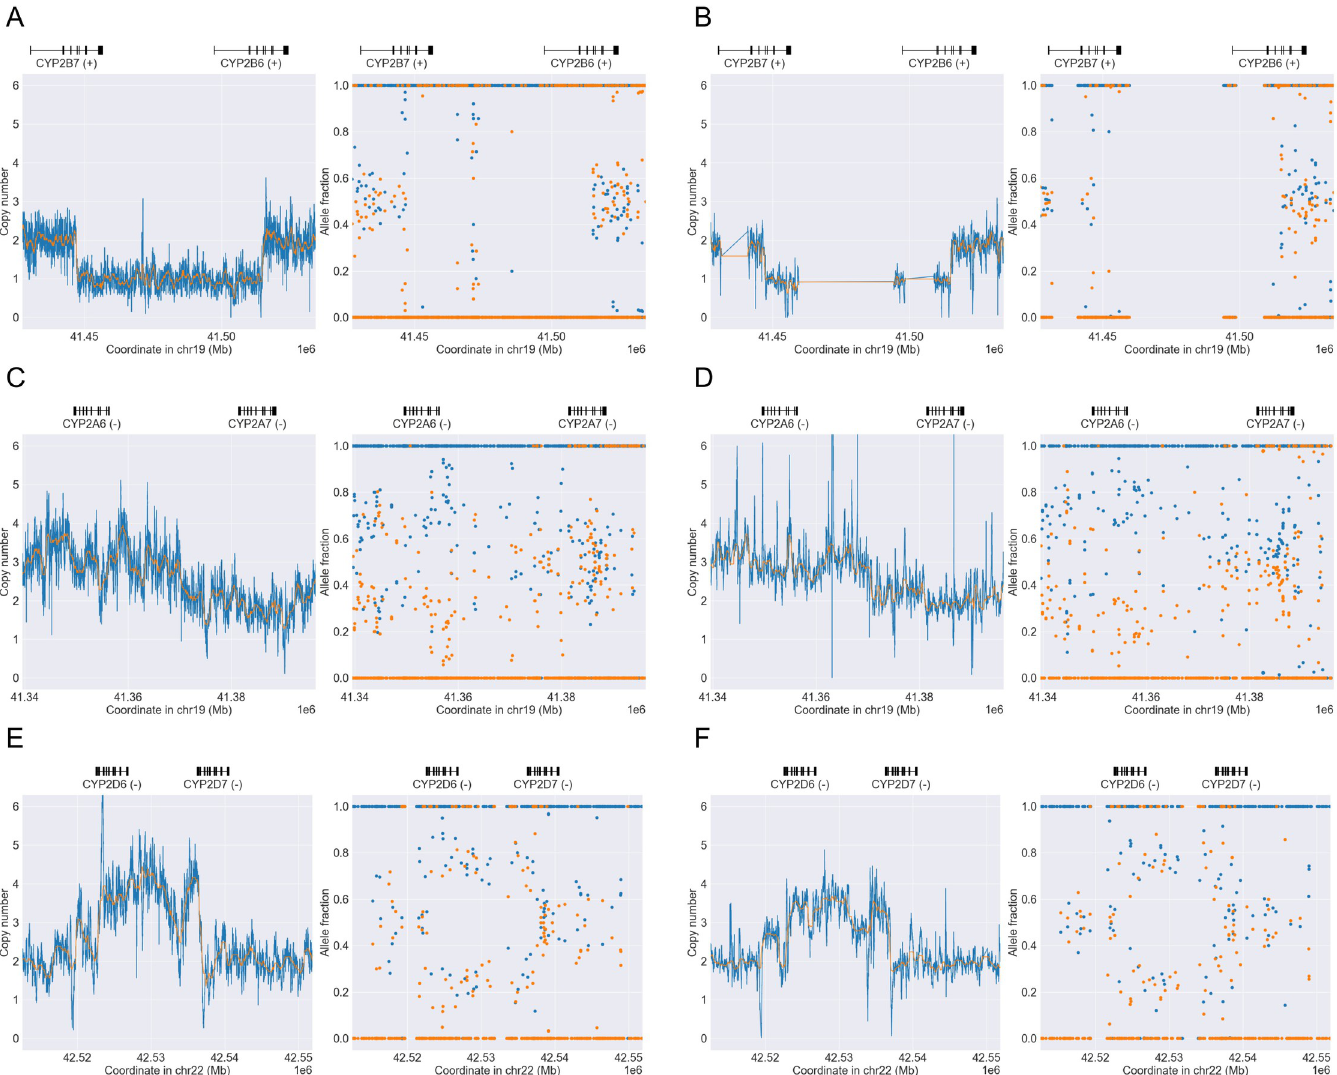
Fig 4. Examples of SVs detected with WGS and ClinPharmSeq. WGS data are shown in the left panels (A, C, and E) while ClinPharmSeq data are shown in the right panels (B, C, and D). Each panel contains a copy number profile and an allele fraction profile created by PyPGx. (A-B) CYP2B7/CYP2B6 hybrid in African sample NA19178 with a CYP2B6 � 6/ � 29 diplotype. (C-D) Gene duplication in African sample NA18861 with a CYP2A6 � 1x2/ � 25 diplotype. (E-F) Complex CYP2D6/CYP2D7 hybrid in East Asian sample NA18526 with a CYP2D6 � 1/ � 36x2+ � 10